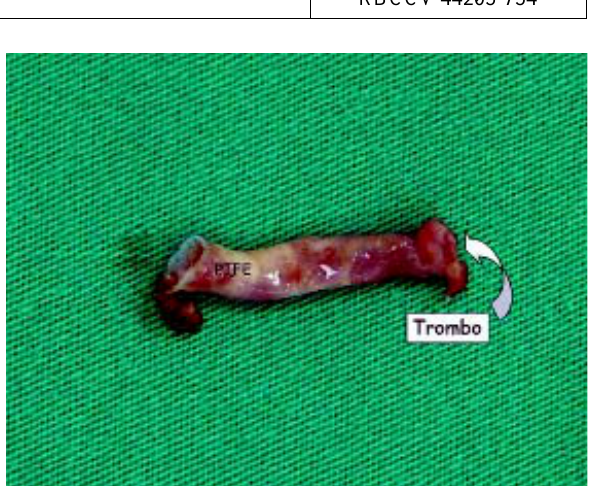
Fig. 1 - Enxerto de politetrafluoretileno (PTFE) com trombo típico de endoarterite infecciosa na extremidade